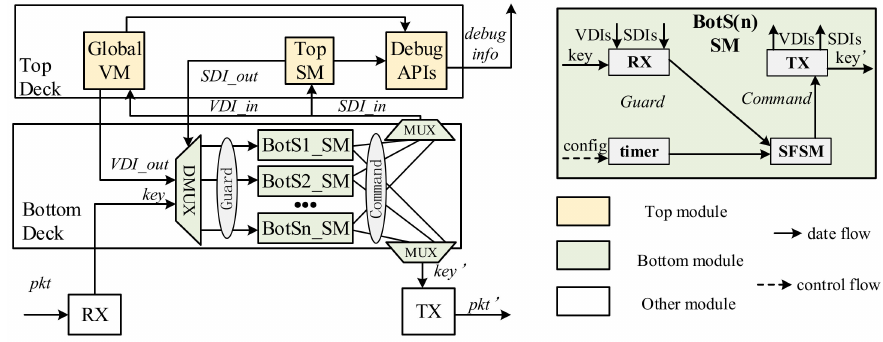
Figure 5. The hardware design of